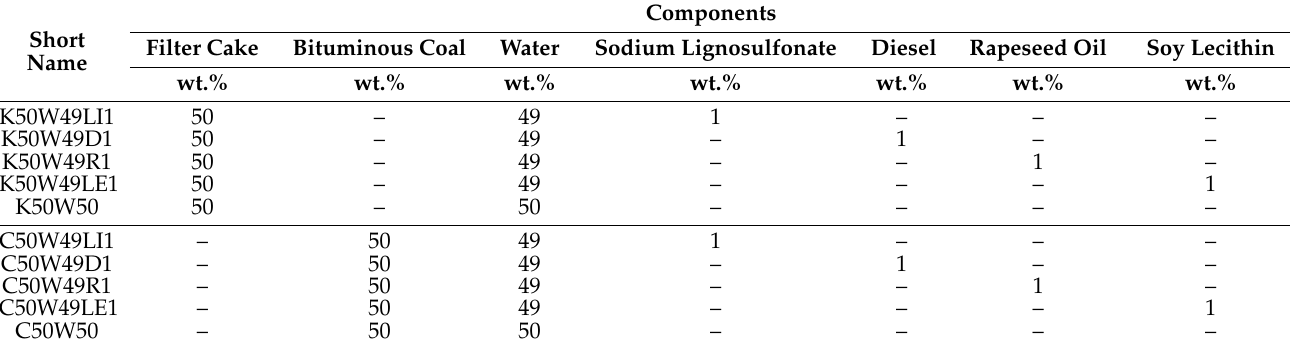
Table 3. Slurry fuels used in the